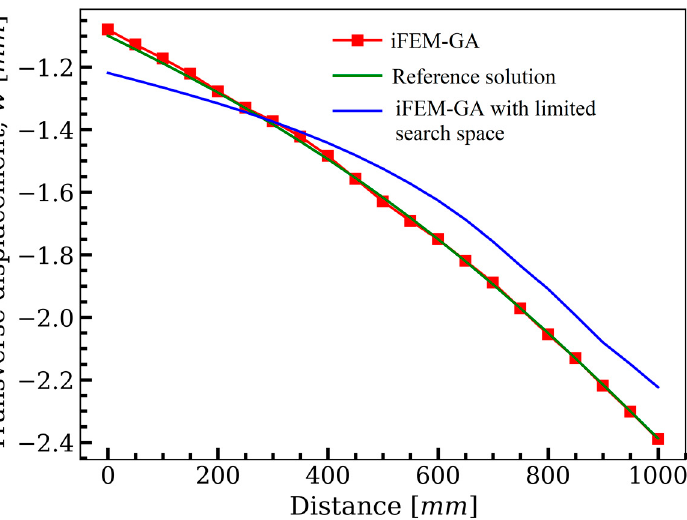
Figure 14. The comparison of the deflection of the plate in Figure 10, path obtained with iFEM-GA analysis, iFEM-GA analysis with limited search space, and reference solution through the defined